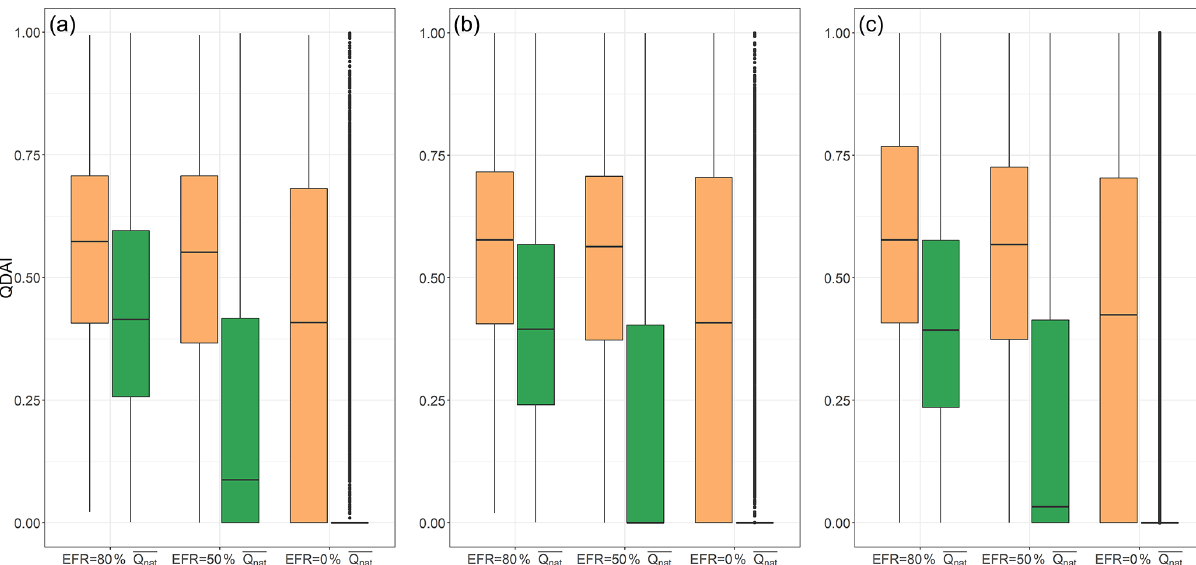
Figure 8. Global distribution of QDAI in August 2003 (left) and December 2003 (middle) and for all 360 months of the reference period (right), computed with alternative assumptions about EFR for grid cells with humid and (semi)arid conditions. Grid cells where all three EFR assumptions result in QDAI = 0 are not included.